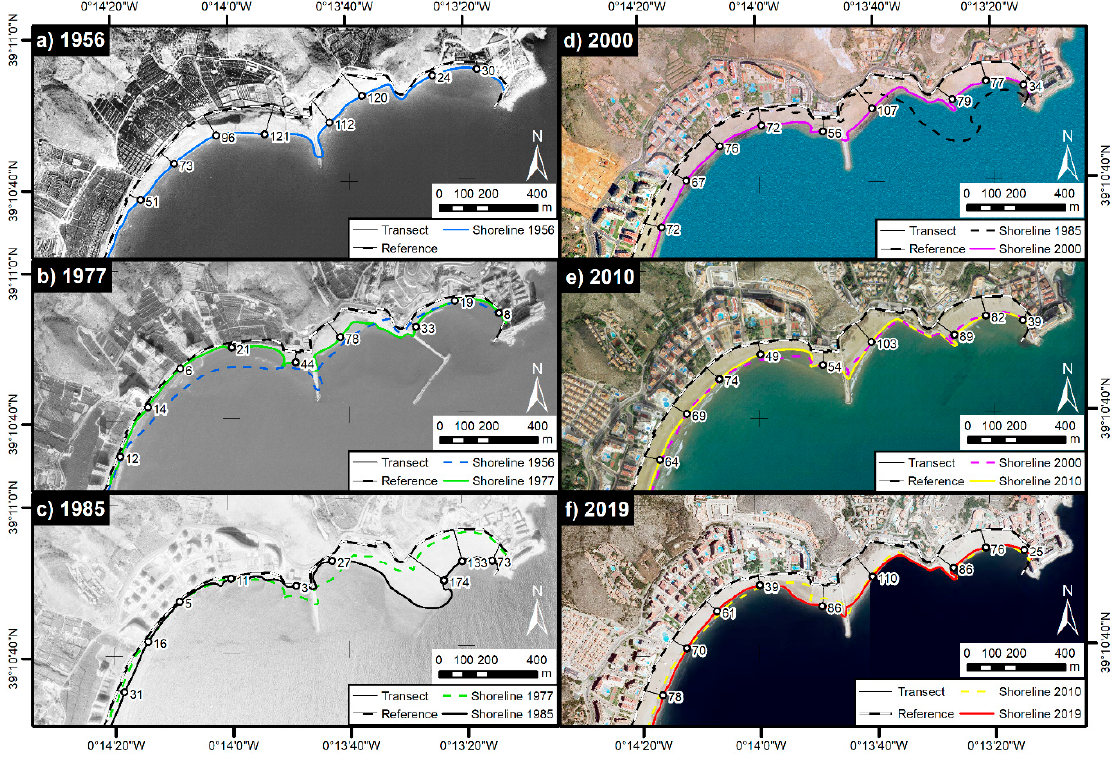
Figure 5. Shoreline evolution and beach width in ( a ) 1956, ( b ) 1977, ( c ) 1985, ( d ) 2000, ( e ) 2010 and ( f )